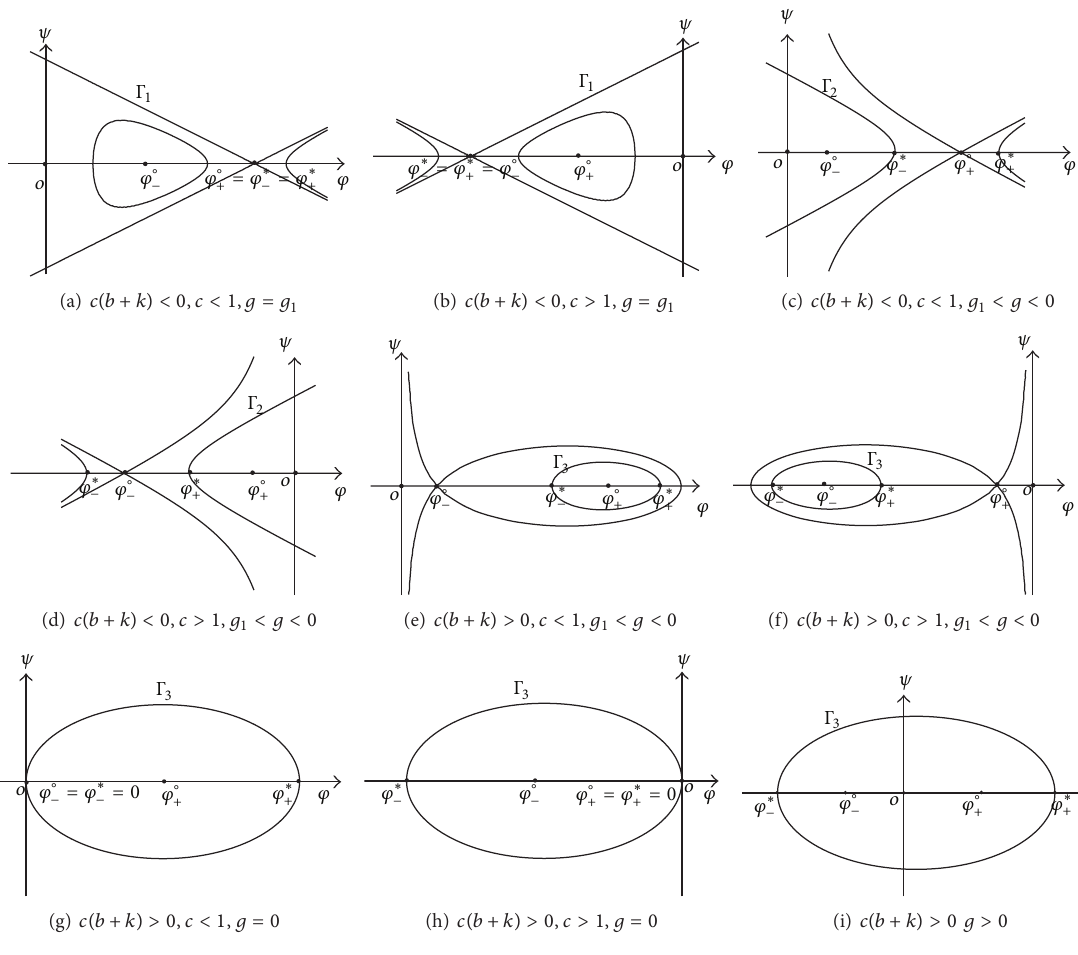
Figure 5: The phase portraits of system